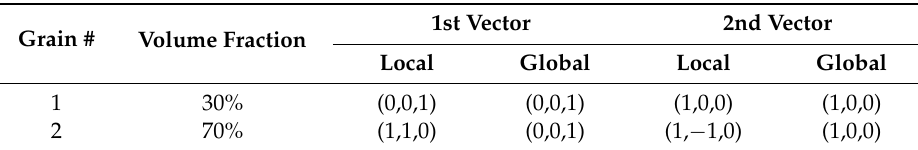
Table 1. Grain data used for studying the simple polycrystal